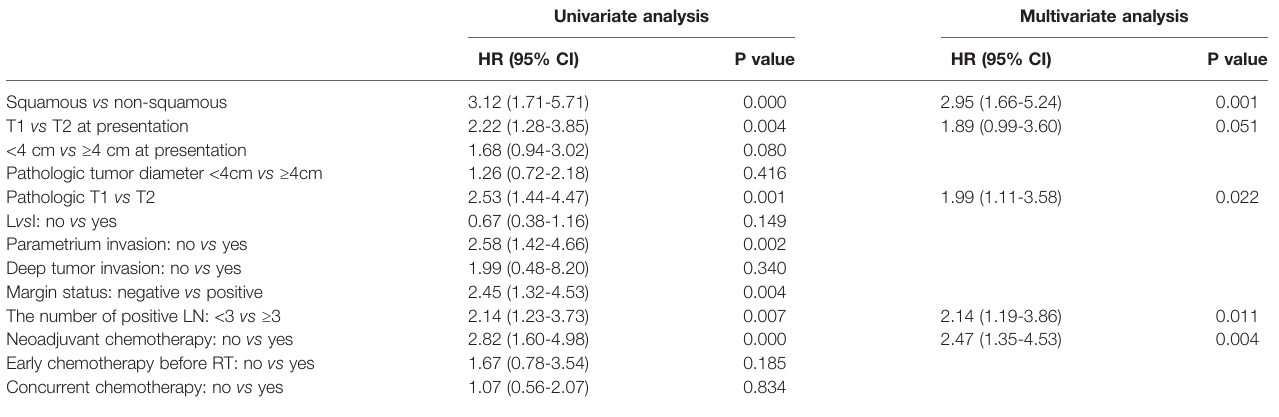
TABLE 3 | Factors predicting overall survival in LN involved early-stage cervical